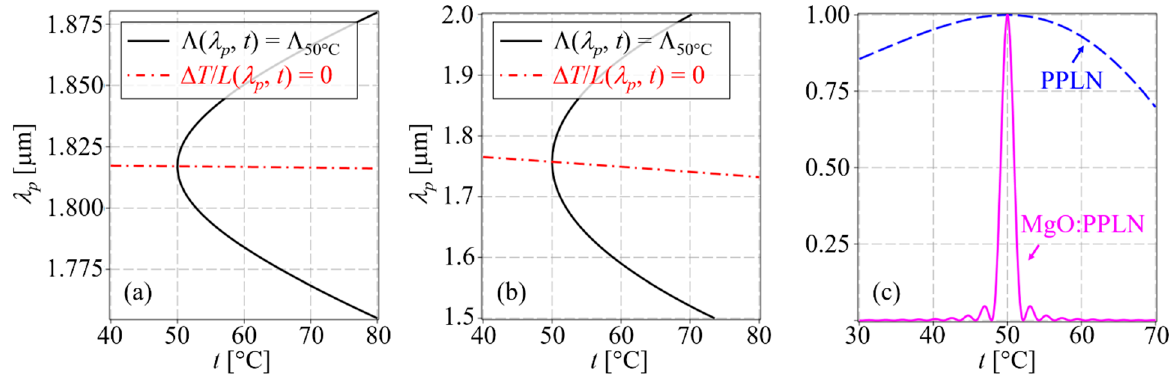
Figure 7. Temperature behaviors of the resonant λ p for the first order QPM and the temporal walk-offs in ( a ) PPLN and ( b ) 5 mol%-MgO:PPLN; ( c ) the spectral responses of the PP crystals to temperature.